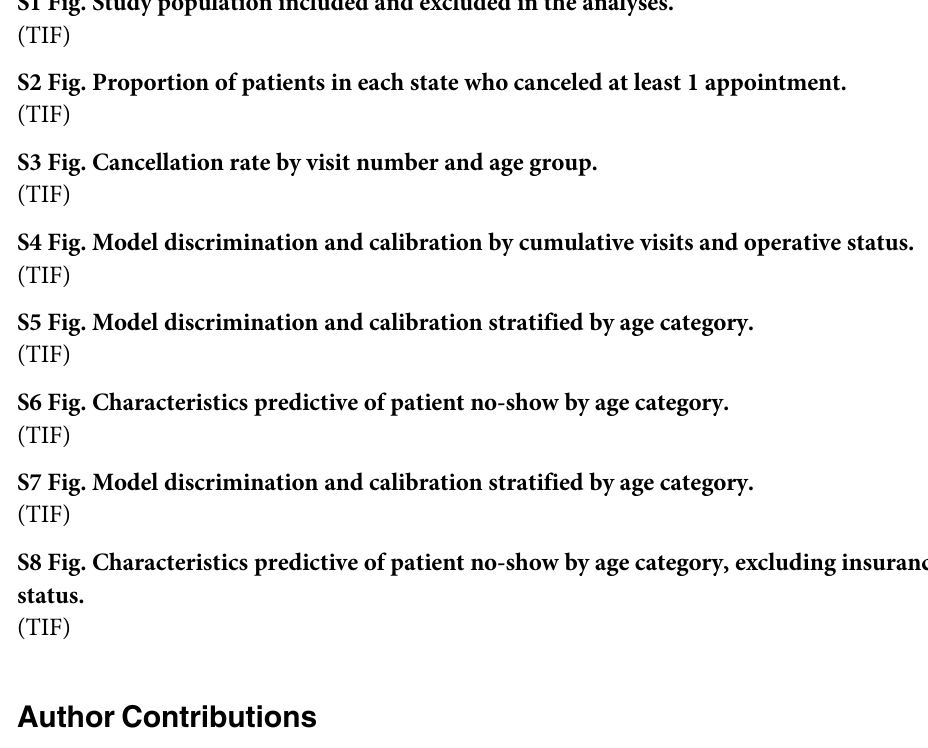
S1 Fig. Study population included and excluded in the analyses. S2 Fig. Proportion of patients in each state who canceled at least 1 appointment. S3 Fig. Cancellation rate by visit number and age group. S4 Fig. Model discrimination and calibration by cumulative visits and operative status. S5 Fig. Model discrimination and calibration stratified by age category. S6 Fig. Characteristics predictive of patient no-show by age category. S7 Fig. Model discrimination and calibration stratified by age category. S8 Fig. Characteristics predictive of patient no-show by age category, excluding insurance